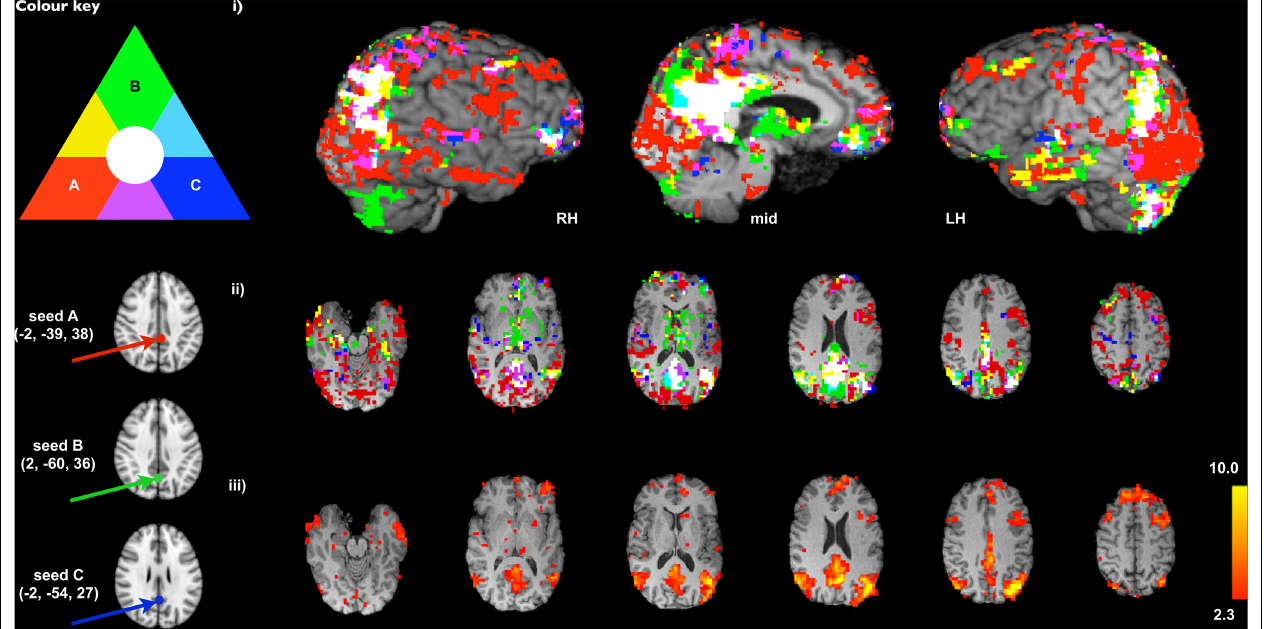
images on selected slices in the space of the subject’s high resolution MRI (cluster-corrected z = 2.3, p < 0.05). It is clear from the extent of primary (non-overlapping) colours visible (largely red and green), particularly in prefrontal, occipital lobes and subcortical regions, that variations inherent in the seed- selection process can result in a large amount of variability into SCA analysis and subsequent interpretations. (iii) ICA-derived DMN map (Colour bar shows Z -statistic